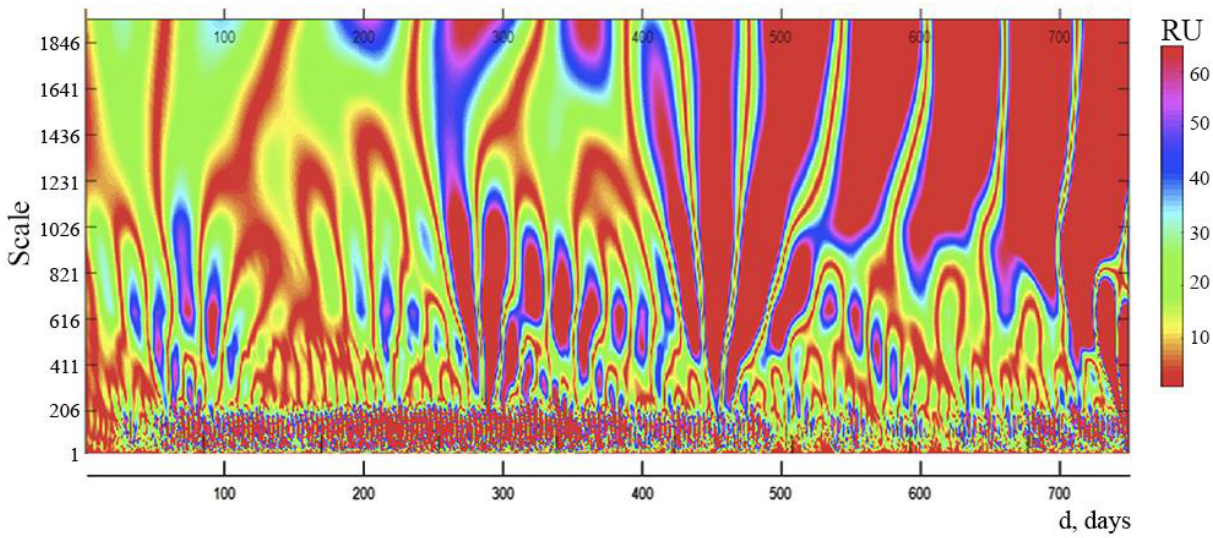
Figure 3. Wavelet spectrum of a continuous function N(d), representing the time course of new cases of daily COVID-19 infection in Russia during the study period. The color scale determines the amplitude of the spectrum in relative units (RU).